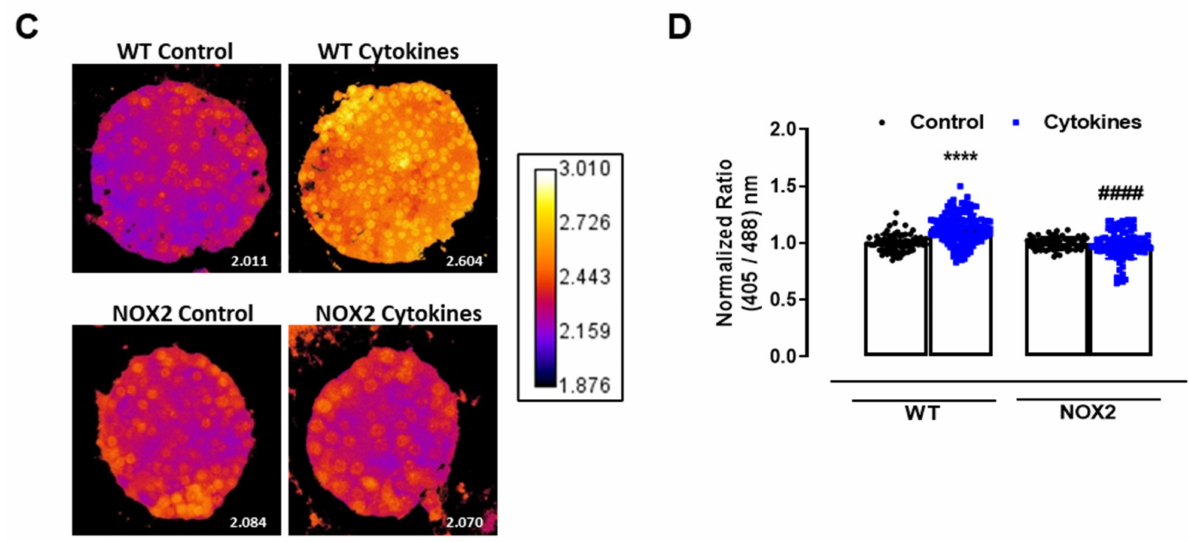
Figure 2. The role of NOX2 in the ROS production of pancreatic islets exposed to proinflammatory cytokines. ( A ) Superoxide production from wild-type (WT), NOX1 KO (NOX1) or NOX2 KO (NOX2) islets in the absence (Ctrl) or presence of proinflammatory cytokines after different periods of exposure, as indicated. The fluorescence intensity was analyzed by flow cytometry using DHE dye. The results are presented as the mean ± SD of 6–14 independent experiments. A.U.: arbitrary units. ( B ) Dynamic levels of cytosolic/nuclear H 2 O 2 of the islets from roGFP2-Orp1 mice incubated with proinflammatory cytokines in the absence or presence of 20 µ M of the NOX2 inhibitor GSK2795039 (GSK). The fluorescence intensity was captured every 10 min for 18 h. The results are presented as the normalized ratio (405/488 nm) and mean ± SD of 3 independent experiments. ( C , D ) NOX2 KO mice and roGFP2-Orp1 mice were crossbred in order to obtain NOX2KO:roGFP2- Orp1. C57BL/6J WT mice and roGFP2-Orp1 mice were crossbred in order to obtain proper heterozygous controls. The islets were incubated in the absence (Ctrl) or presence of proinflammatory cytokines for 4 h and 30 min. ( C ) Representative images of the islets from the control heterozygous (WT) and NOX2KO:roGFP2-Orp1 (NOX2) mice. The color temperatures reflect the normalized 405/488 ratio, from black/purple (non-oxidized sensor) to yellow/white (completely oxidized sensor), thus reflecting the H 2 O 2 levels. ( D ) H 2 O 2 levels represented as the normalized ratio (405/488). The results are expressed as the mean ± SD of individual islets from 6–9 independent experiments. ( A ) * p < 0.05 when compared to the Ctrl. One-Way ANOVA + Sidak. ( D ) **** p < 0.0001 versus the respective controls in same genotypes; #### p < 0.0001 versus the WT cytokines. One-Way ANOVA + Tukey’s. Proinflammatory cytokines mix: 10-U/mL IL-1 β + 100-U/mL TNF + 14-U/mL IFN- γ